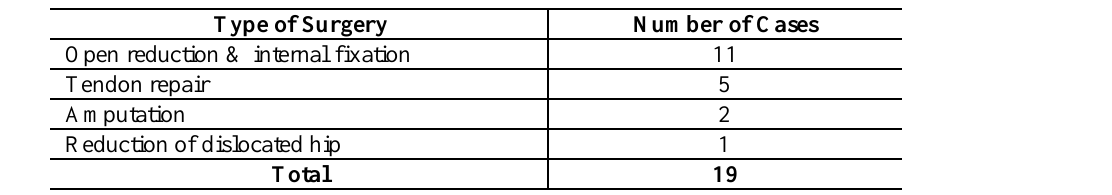
Table IV : Major Orthopedic Surgery